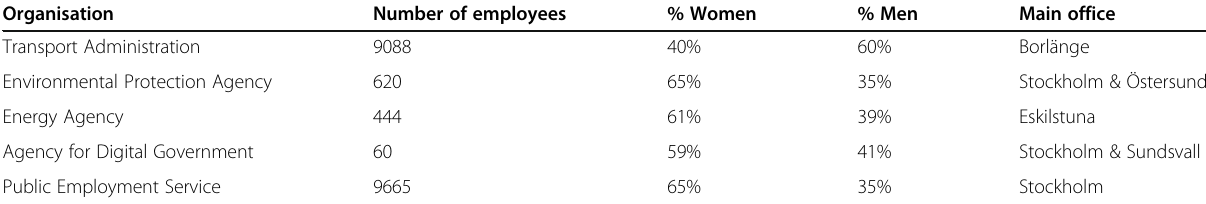
Table 1 Statistics on Selected Public Agencies